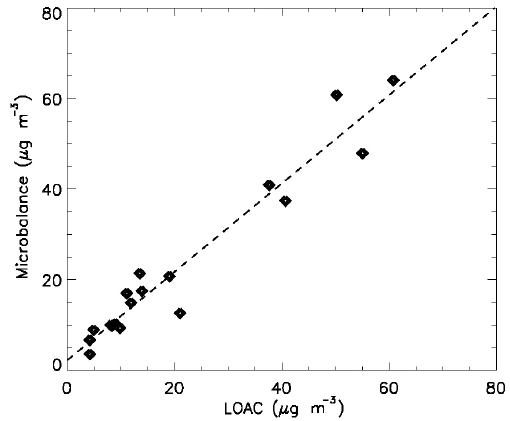
Figure 21. Correlation between LOAC and TEOM microbalance mass concentrations in indoor air (averaged over 24h); particles have been injected with various concentrations to document a large range of mass